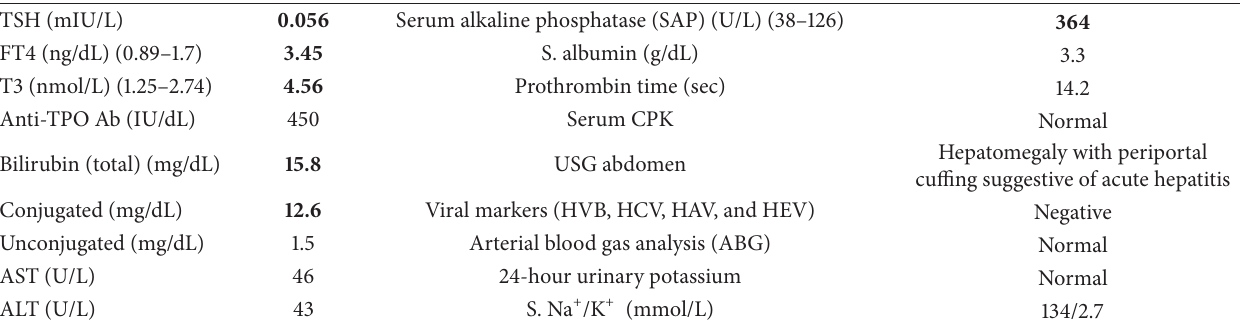
Table 1: Baseline investigations of the